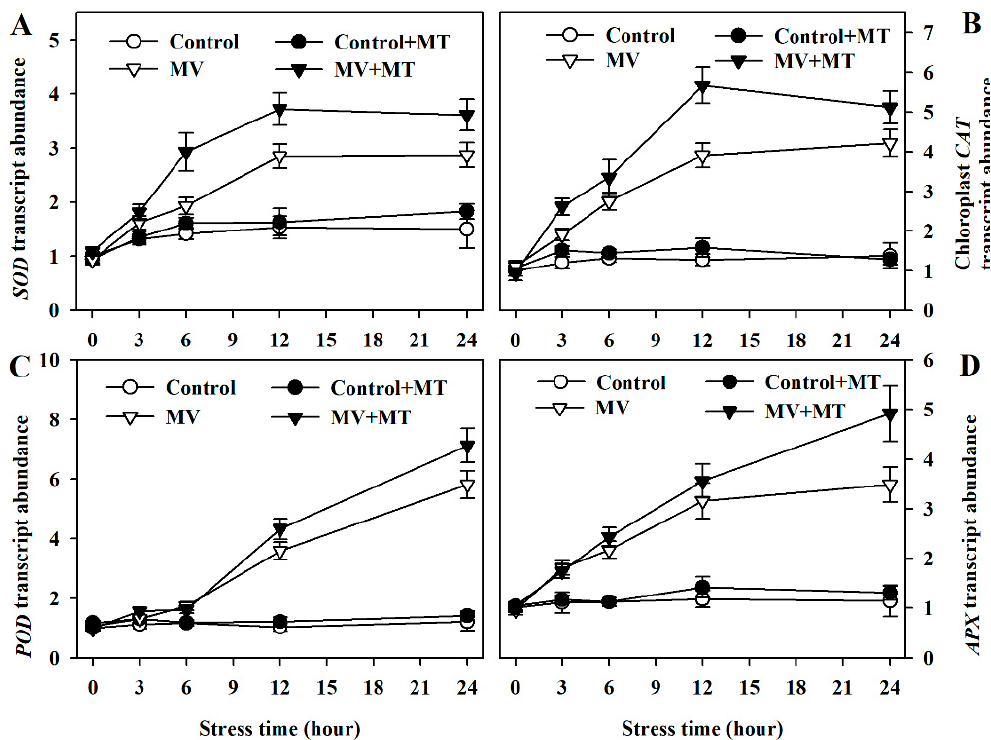
Figure 5. Relative transcript abundance of genes for antioxidant enzymes as affected by melatonin in poplar leaf discs under MV stress. ( A ) Cu/Zn-SOD ; ( B ) CAT ; ( C ) POD ; ( D ) Chloroplast APX . Relative transcript abundance was determined by quantitative real-time PCR using total RNA isolated from poplar leaf discs collected at 0, 3, 6, 12 and 24 h following MV treatment. The values presented are means ± SDs ( n = 3).